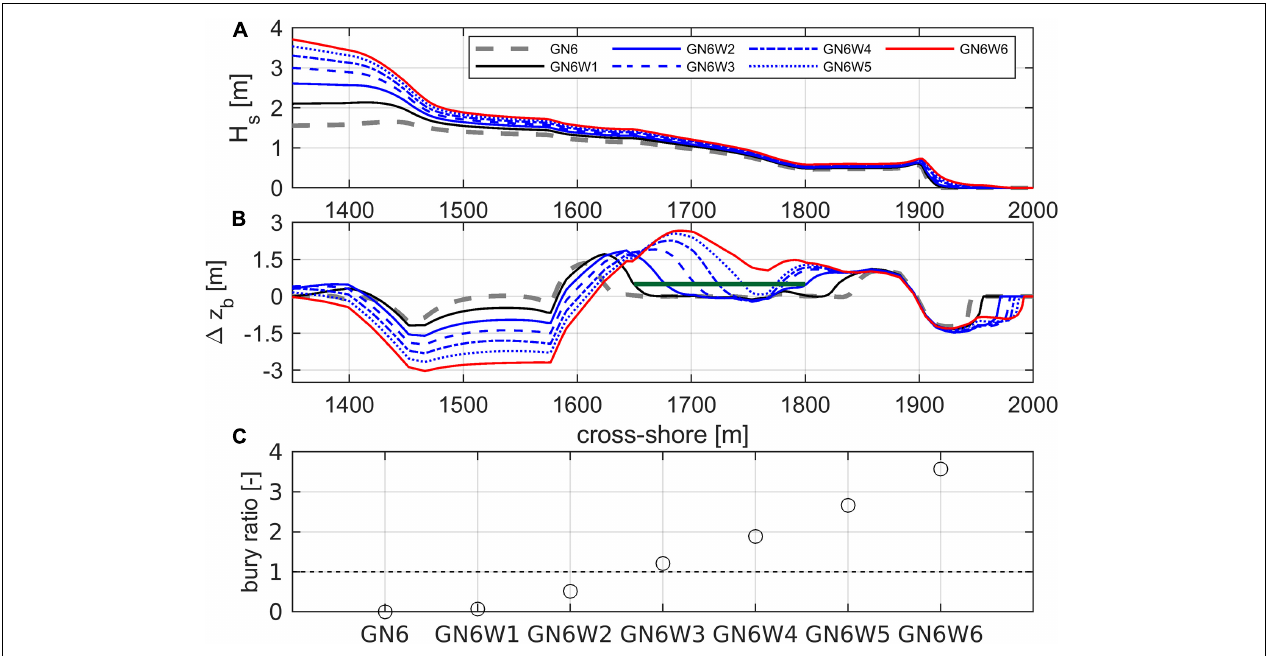
FIGURE 10 | Sensitivity of seagrass to offshore wave conditions, showing: (A) wave height distribution; (B) seabed change after 100 days simulation; and (C) meadow averaged bury ratio.